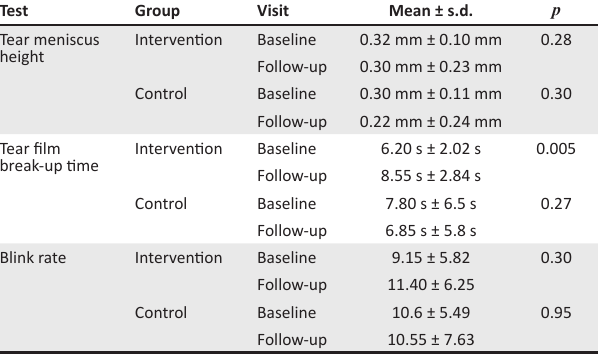
FIGURE 6: Box plots for tear film break-up time measurements for the control group. No significant changes between visits. TABLE 2: Group means and standard deviations for clinical variables for baseline and follow-up visits for both intervention and control groups, for each indicated variable, with the outcomes of paired t -test intergroup comparisons.